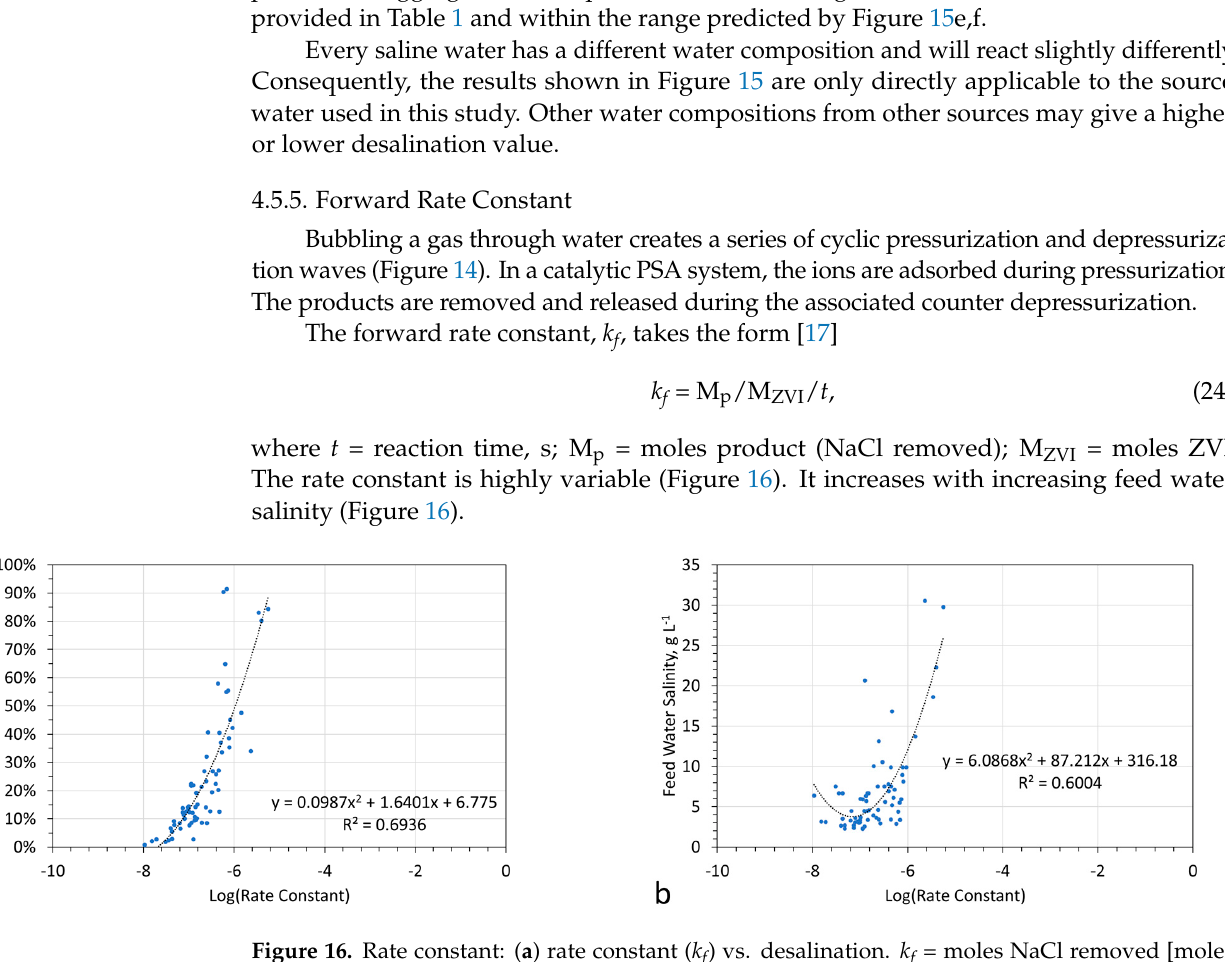
Figure 16. Rate constant: ( a ) rate constant ( k f ) vs. desalination. k f = moles NaCl removed [moles Fe 0 ] − 1 [reaction time, s] − 1 ; ( b ) rate constant vs. feed water salinity.